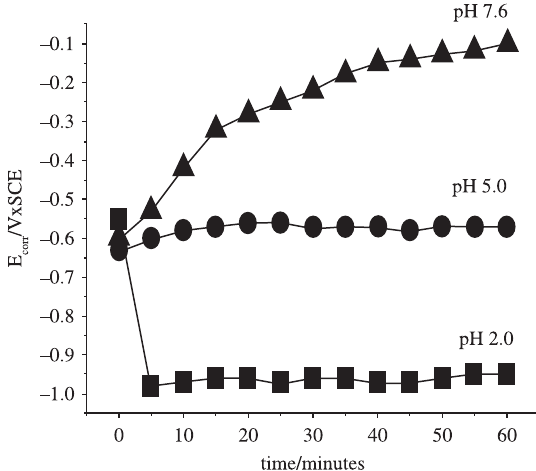
Figure 1. OCP variation of Ti6Al4V alloy as a function of immersion time in the citrate buffers containing 0.1 M NaF; ( ▲ ) pH 7.6, ( ● ) pH 5.0, ( ■ ) pH 2.0.